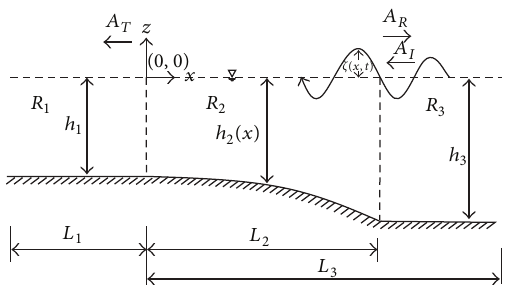
Figure 2: The side view diagram of the physical model studied. The water wave amplitude 𝐴 𝑤 for 𝑤 = 𝐼, 𝑅 , and 𝑇 represents the incident (travelling from right to the left hand side), reflected, and transmitted water waves, respectively. The harbor is formed for three regions 𝑅 1 , 𝑅 2 , and 𝑅 3